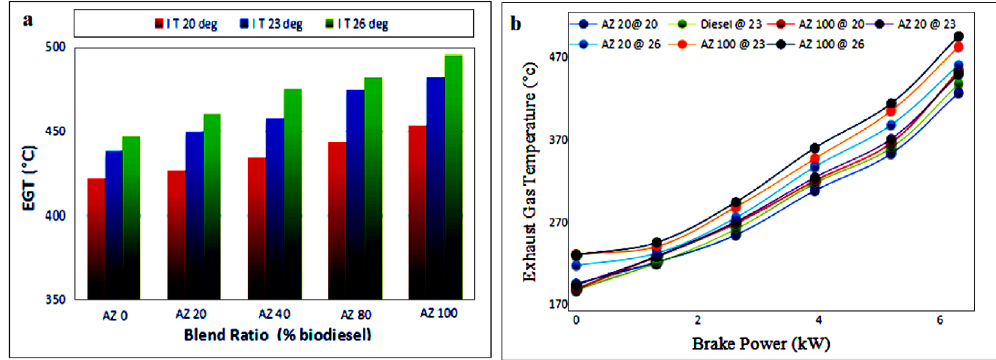
Figure 7. Graphs of Exhaust Gas Temperature vs. blend ratio and brake power.